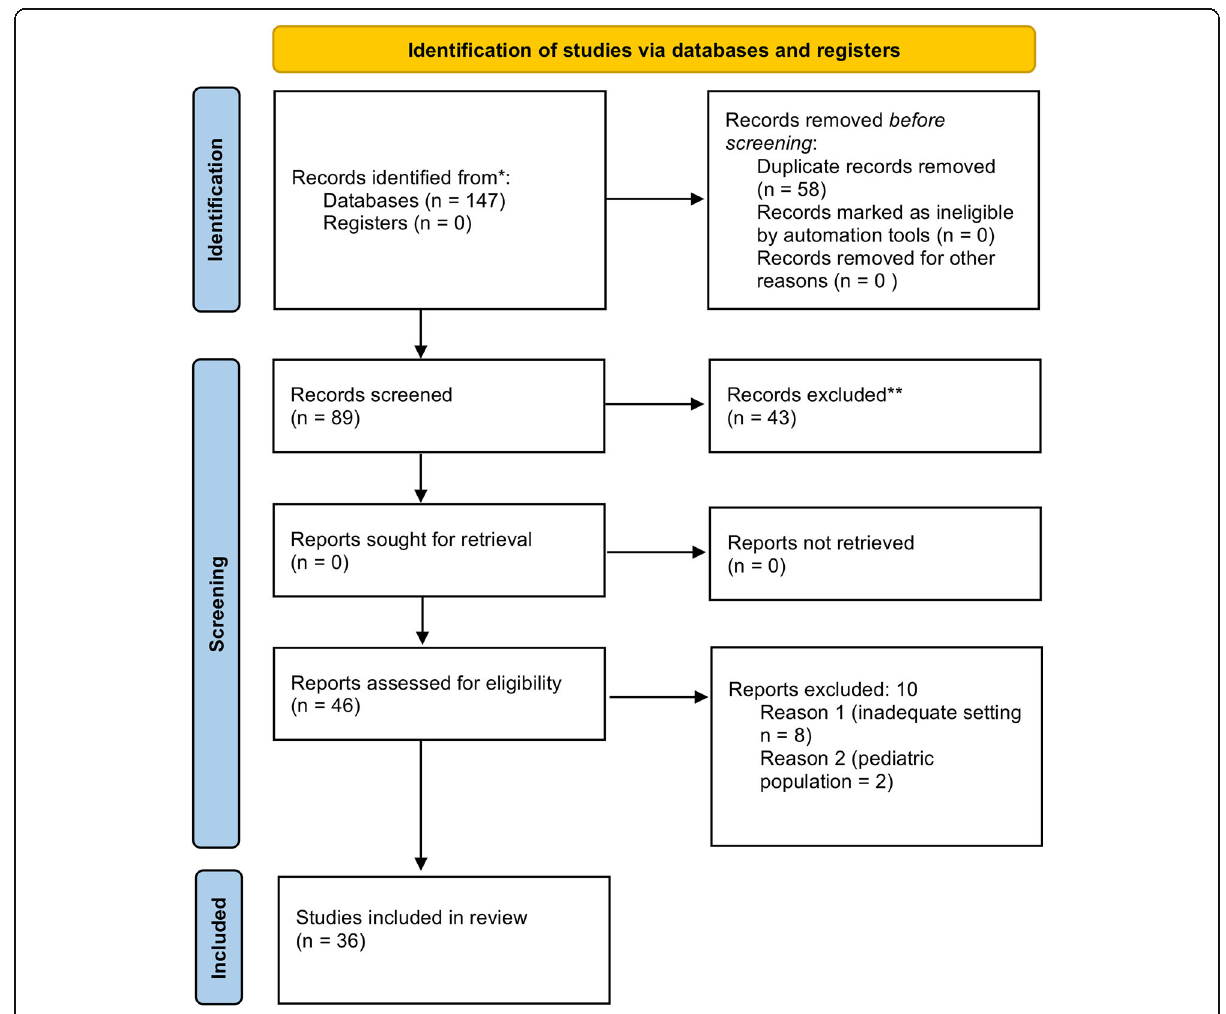
Fig. 1 Preferred Reporting Items for Systematic Reviews and Meta-Analysis (PRISMA flow chart) illustrating the process of selecting eligible publications for inclusion in the systematic